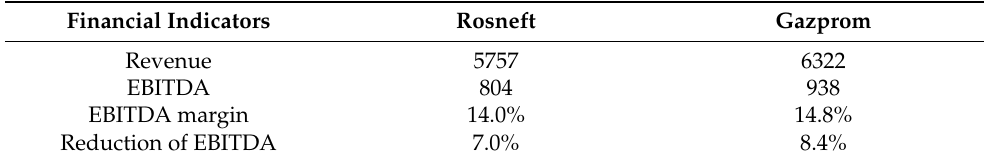
Table 5. Financial indicators, billion rubles.